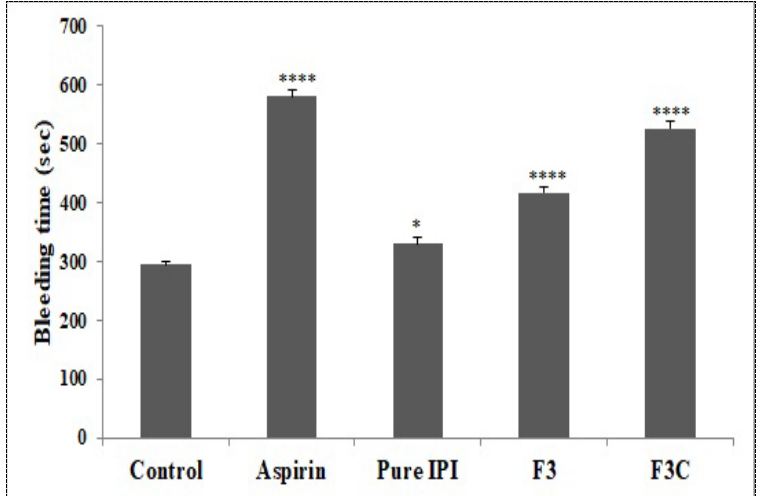
Figure 5. Effect of various treatments on tail bleeding time in experimental animals. Results are expressed as Mean ± SEM, ( n = 6), analysed by one-way ANOVA followed by Dunnett’s test of multiple comparison where ns = non-significant, **** p < 0.0001, * p < 0.05 where various treatment groups were compared with control